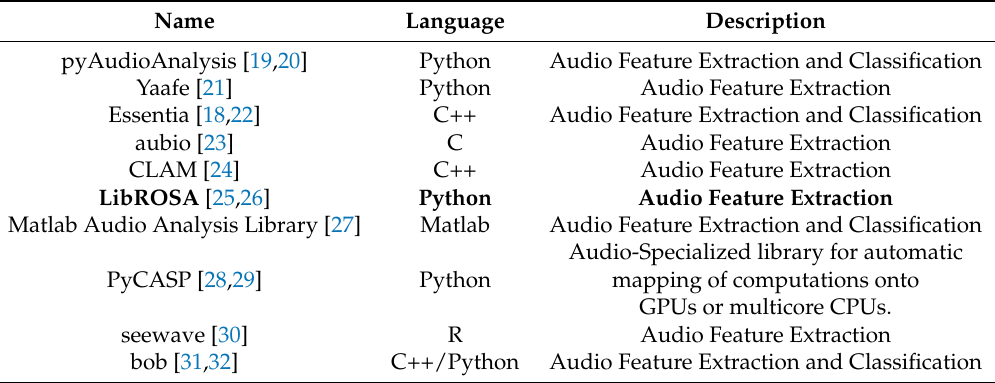
Table 2. List of some libraries for audio analysis. The selected library is highlighted in